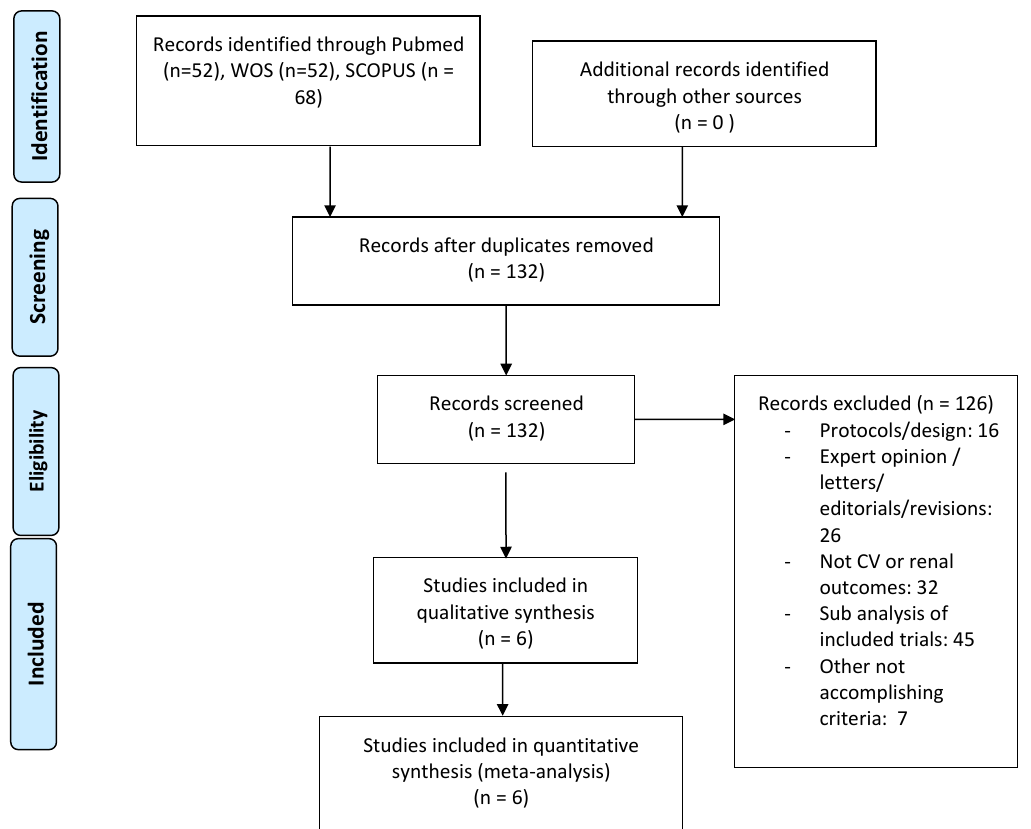
Figure 2. Literature search PRISMA (Preferred Reporting Items for Systematic Reviews and Meta-analyses) consort diagram.